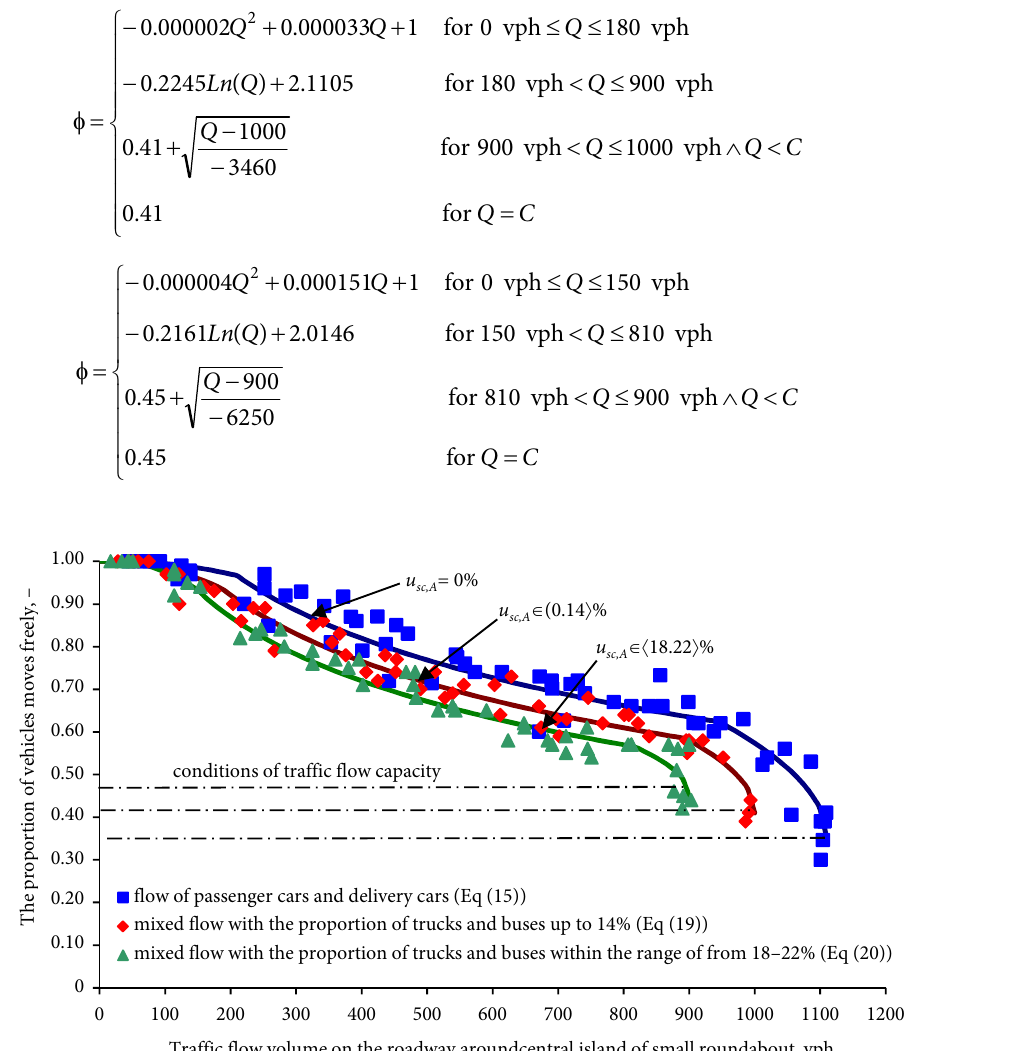
Fig. 3. Comparison of the proportion of vehicles which move freely in a uniform flow in terms of composition (only passenger and delivery cars) and mixed (with the proportion of trucks and buses up to 14% and with the proportion of trucks and buses ranging from